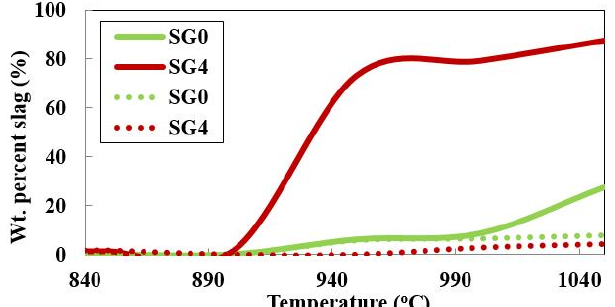
Figure 4. SG4 fraction showing significant difference in slag ‐ liquid amounts in reducing (solid) than oxidizing (dotted) unlike whole